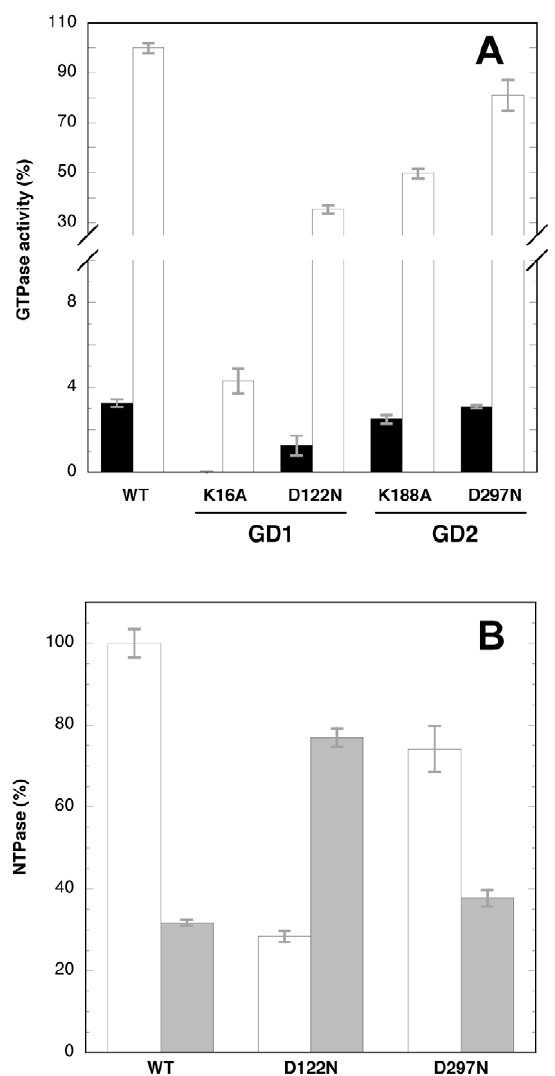
Figure 7. GTPase or XTPase activities of wild-type or mutated EngA. A , the GTPase activity of the wild-type EngA (WT) or the mutants was measured in the presence of 1 mM GTP using a coupled-enzymatic assay in the absence (black bars) or in the presence of 300 mM KCl (white bars); the results are expressed relative to that of the wild-type EngA in the presence of 300 mM KCl (100% corresponding to 100 m mol GTP hydrolyzed/min/mg proteins). The activity of the K16A mutant is undetectable in the absence of potassium. B , same as A but 200 m M of nucleotides were used in the presence of 300 mM KCl (100% corresponding to 77 m mol GTP hydrolyzed/min/mg proteins); white bars, GTPase activity; grey bars, XTPase activity. The values represent the mean of three experiments and the standard deviation is indicated as error bars, in grey color.